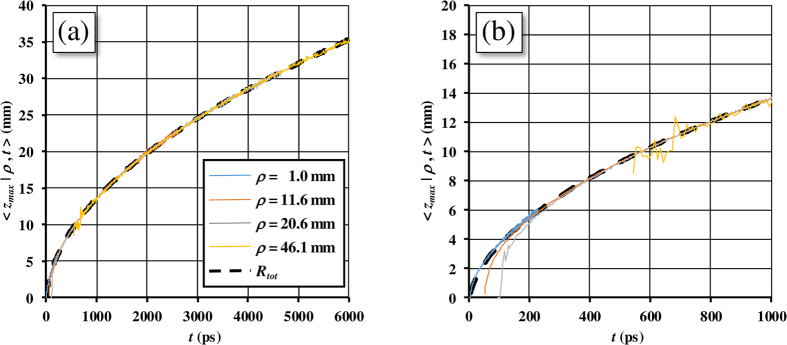
Mean maximum TD penetration depth, 〈zmax|ρ, t〉, obtained with MC simulations plotted versus time for different ρ.A semi-infinite diffusive medium with μa = 0,  and nint = next = 1.4 has been considered. The result obtained for the total reflectance Rtot is also shown (black dashed line). In panel (b) it is shown a detail of panel (a) with an emphasis on the time range from 0 to 1000 ps.